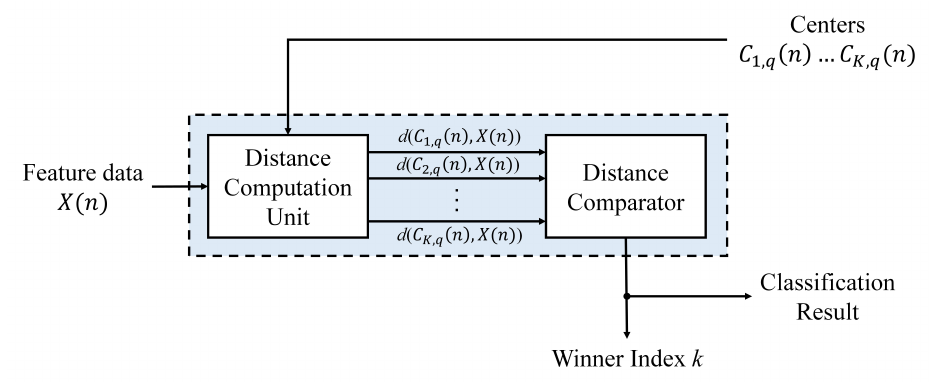
Figure 9. The block diagram of the winner selection unit. There are two modules in the circuit: distance computation unit and distance comparator. The circuit fetches K centers associated with a channel q and produces the classification results and winner